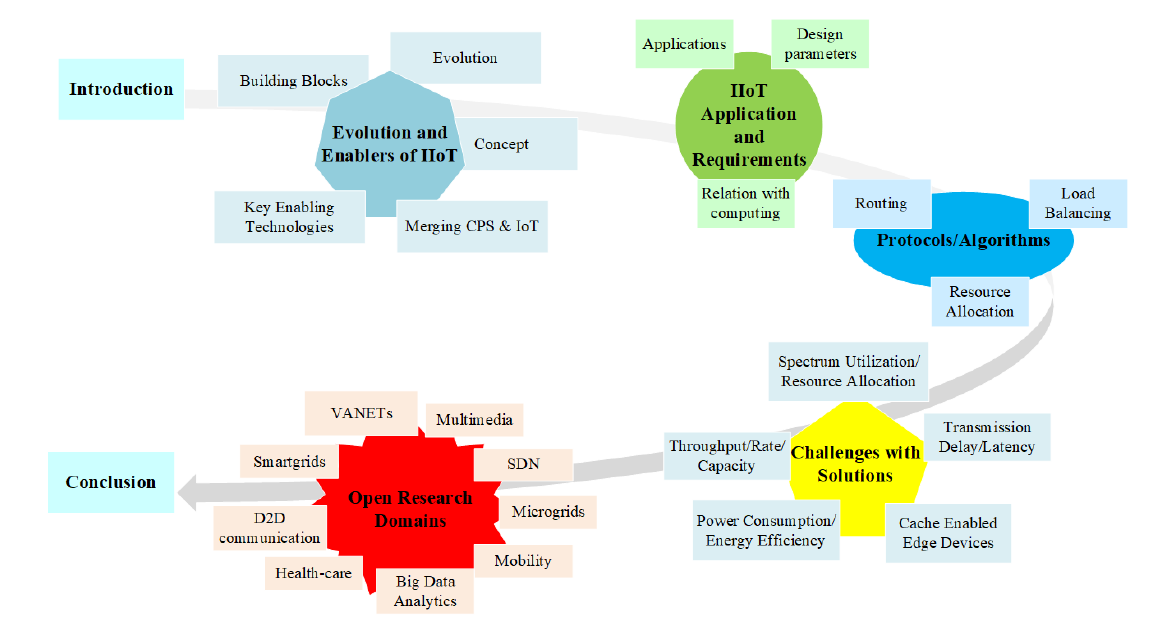
Figure 2. Flow of the